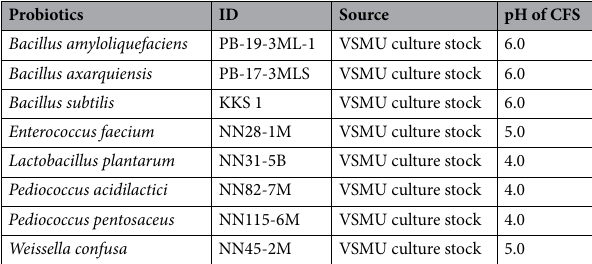
Table 2. Characteristics of CFS from selected probiotics.